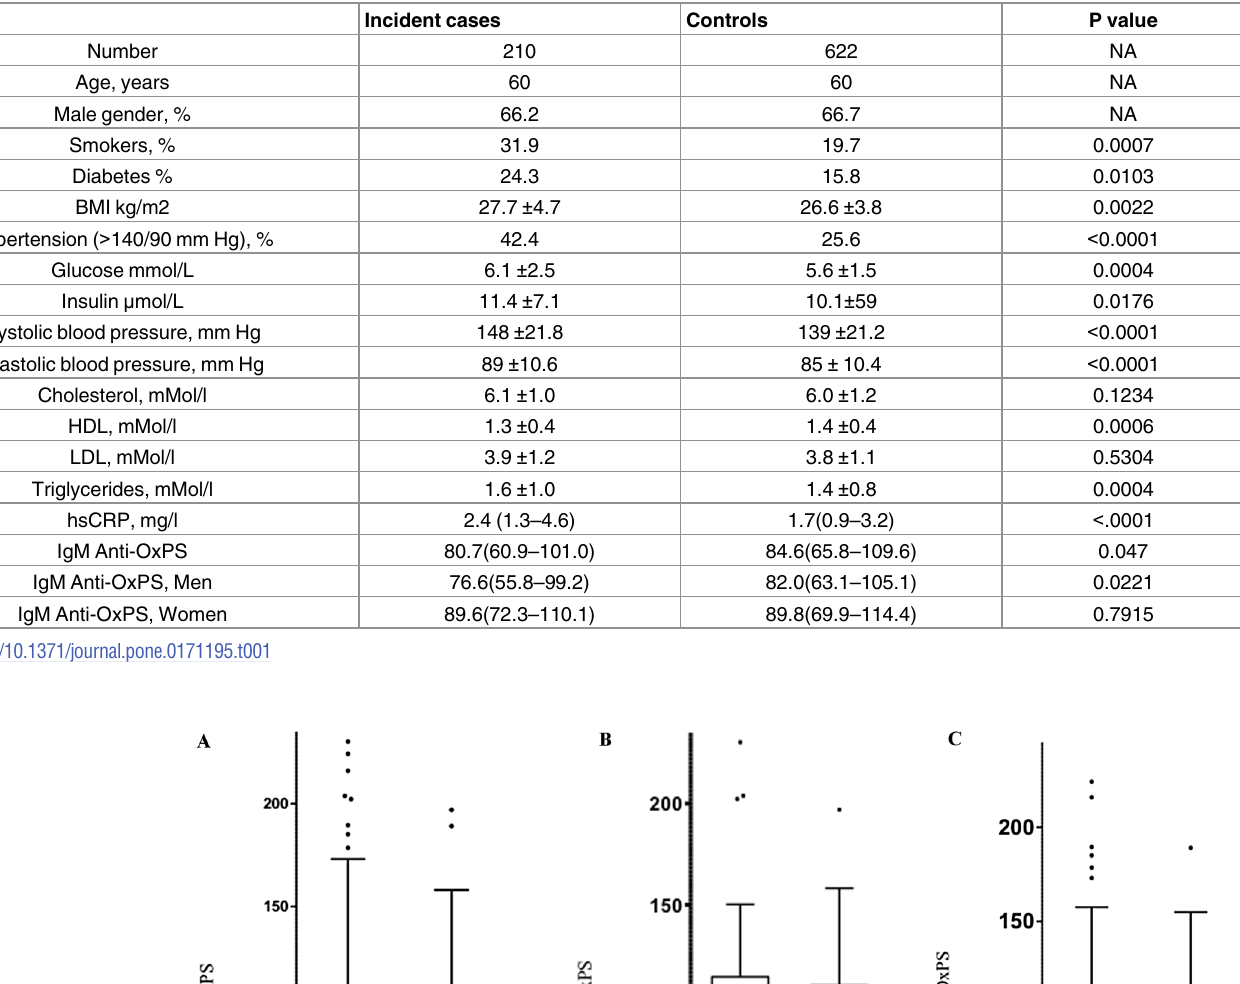
Table 1. Baseline characteristics among incident CVD cases and matched controls.